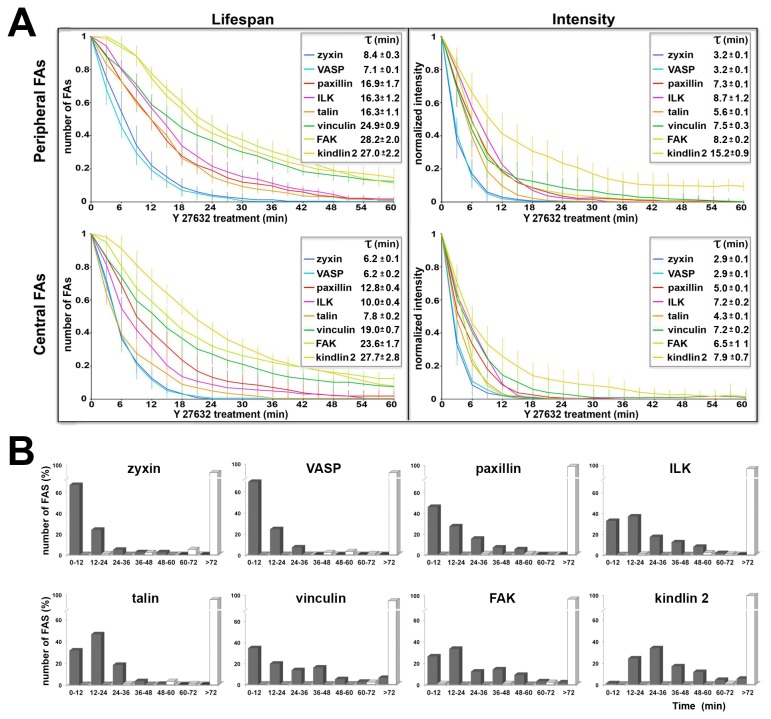
Differential dissociation rates of adhesome components in cells treated with Y-27632.(A) FA lifespan (expressed as the relative number of surviving FAs) and average normalized fluorescence intensity for each protein, in peripheral and central FAs separately, as tracked by time-lapse video microsopy for a hundred individual FAs. τ values were calculated by fitting the individual decay profiles to a single-exponential function. Note that the order of exit of the different molecules is the same in all graphs, with zyxin and VASP as the first to leave and kindlin 2 as the last. (B) Based on the same dataset shown in A, the differential effect of Y-27632 on the lifespan of the FA proteins tested, in peripheral FAs, is shown for each protein, separately. FA lifespan for each protein is expressed as the percentage of total FA number over time. Untreated cells are shown as white columns; cells treated with Y27632 as black columns.